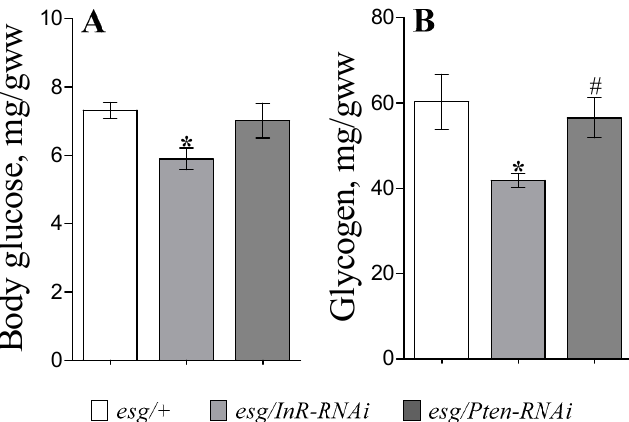
Figure 3. Body glucose contents ( A ) and glycogen amounts ( B ) in flies with IIS modulated in stem and progenitor cells. Flies were used after six days of expression induction by fly transfer to 29 °C. Results represent the mean ± SEM of 4 or 5 replicates per genotype. Group comparisons were performed using ANOVA followed by Newman–Keuls post hoc test. Asterisks indicate significant difference from the control flies ( esg/+ ) ( p < 0.05); hash sign shows significant difference from flies with inhibited IIS ( esg / InR-RNAi ).